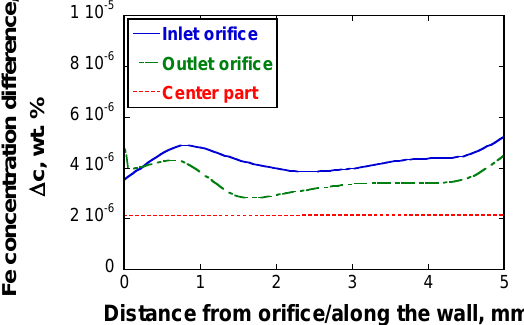
Figure 17. Mass concentration difference of iron at various locations.